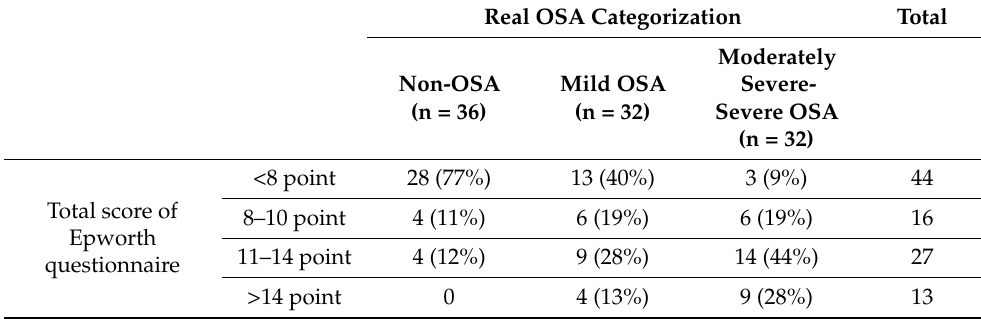
Table 3. Contingency table of frequency distribution of patients, categorized by OSA severity according to AHI values and OSA probability, according to total score of the Epworth questionnaire (the table shows the number of cases per 100 patients and the percentage distribution of scores within each OSA category). OSA: obstructive sleep